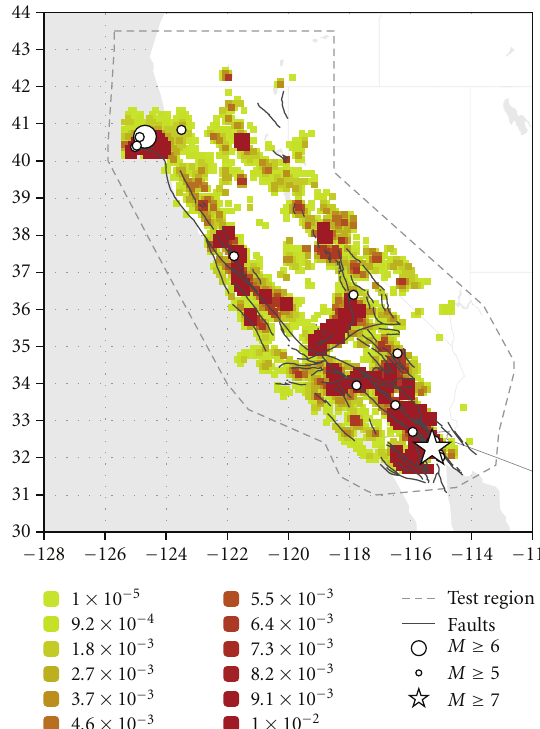
Figure 2: Map of the normalized probabilities λ fi given for the testregion by Holliday et al. [17] using their PI-based forecast. The “hotspots” are shown in red. The test earthquakes are also shown.